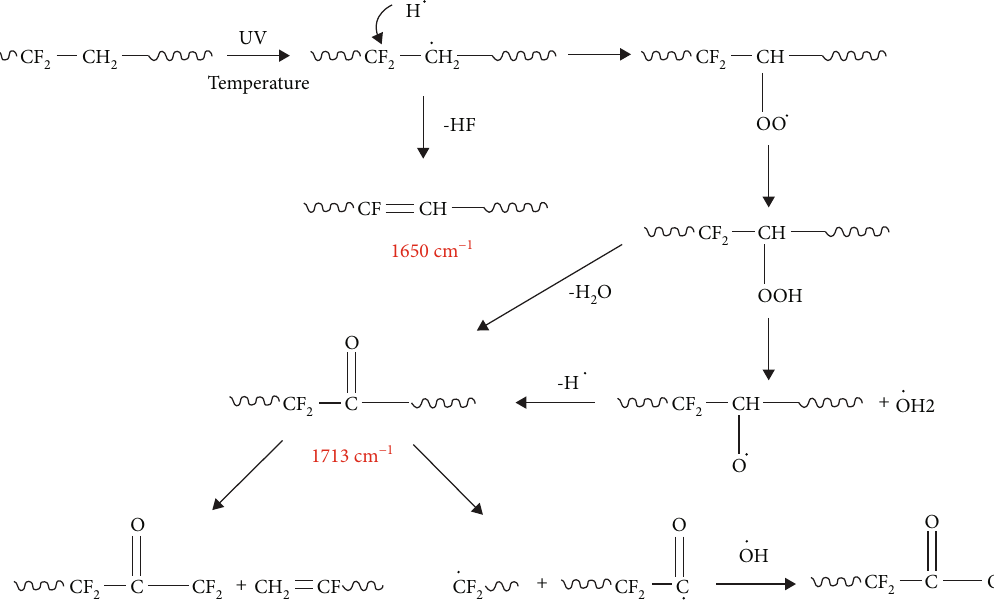
Figure 10: Degradation mechanism of PVDF during service